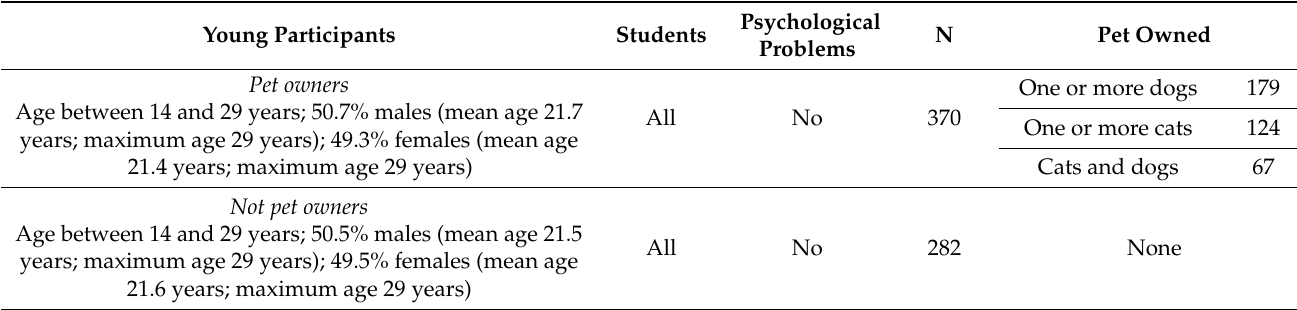
Table 1. Demographics